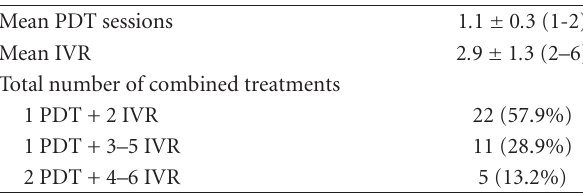
Table 1: Treatments during 12